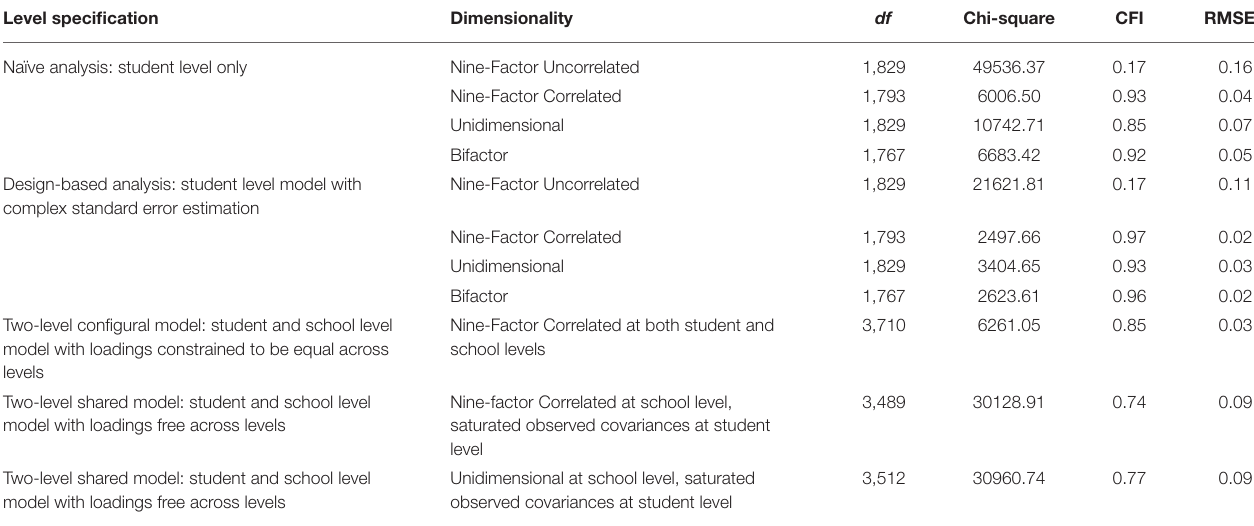
TABLE 4 | Fit statistics for model